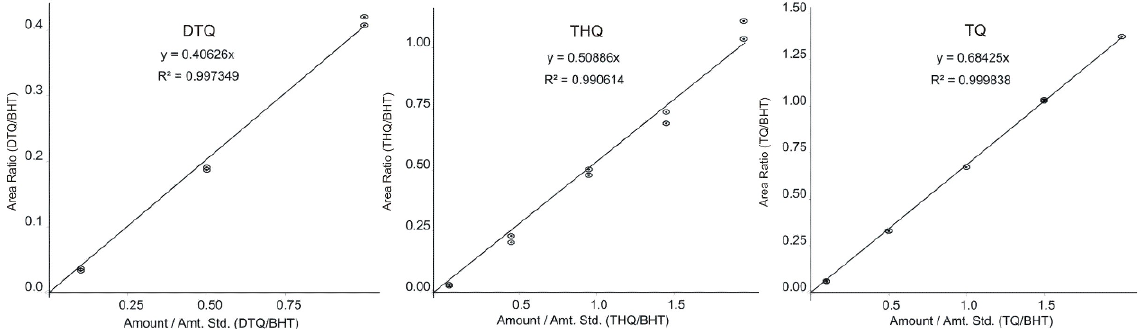
Figure 2. Calibration curves used for quantitative analysis of dithymoquinone (DTQ), thymohydroquinone (THQ), and thymoquinone